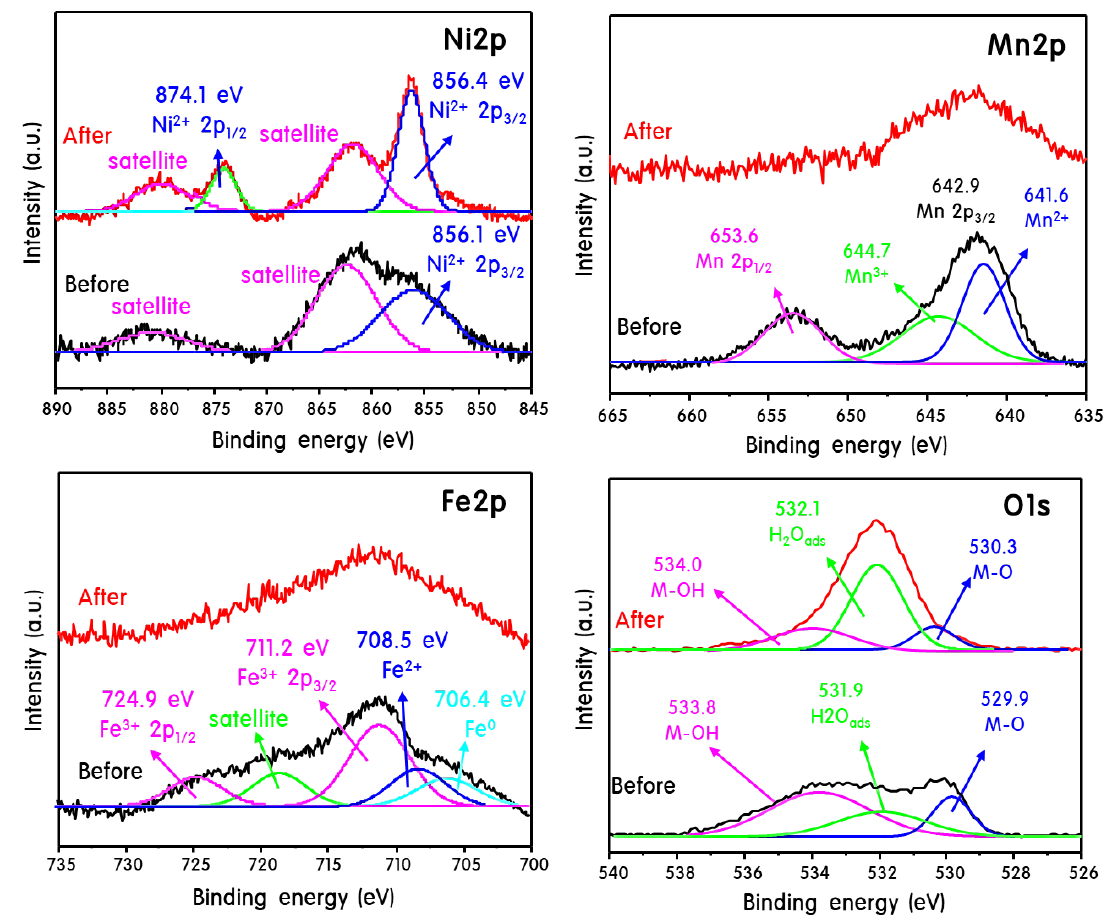
Figure 6. XPS curves of Fe2p, Mn2p, Ni2p, and O1s for the Fe 2 O 3 -MnO / NF electrode after the OER.